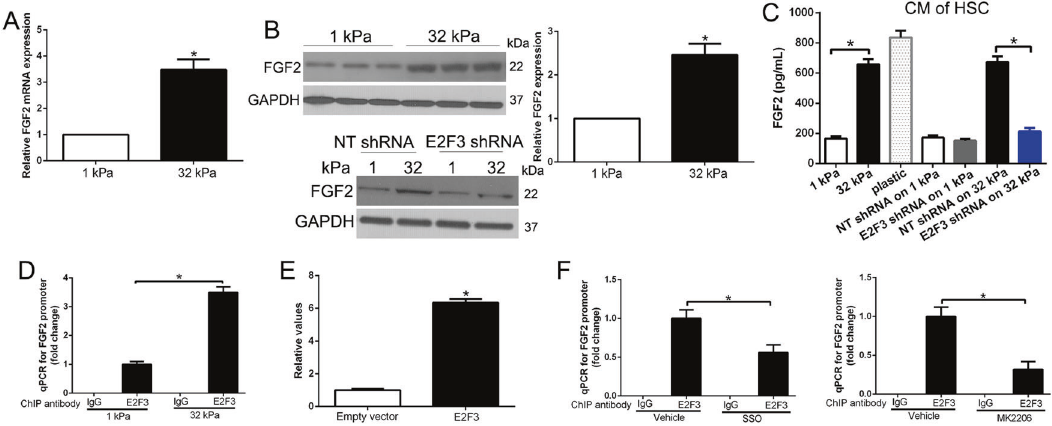
Fig. 5 Stiffness-E2F3 axis promotes transcription of tumor-promoting factors FGF2 of HSCs. A Stiffness increased FGF2 mRNA as revealed by qPCR after reverse transcription. * P < 0.05 by t -test, n = 6. B Stiffness increased FGF2 protein through HSC E2F3. * P < 0.05 by t -test, n = 3. C Conditioned medium (CM) of HSCs on different substrates were collected for ELISA to quantitate HSC-released FGF2. Stiffness promoted HSCs to release FGF2 through HSC E2F3. * P < 0.05 by ANOVA, n = 6. D E2F3/DNA complexes were pulled down by control IgG or anti-E2F3 for ChIP-qPCR and qPCR was performed with primers for FGF2 promoter. The stiffness increased E2F3 on the FGF2 promoter. * P < 0.05 by ANOVA, n = 3. E Luciferase promoter assays in HEK-293A cells of the FGF2 promoter reveal that the addition of an activating E2F3 induces an obvious increase of FGF2 promoter activity. F SSO or MK2206 reduced E2F3 on FGF2 promoter of HSCs. * P < 0.05 by ANOVA, n = 3.